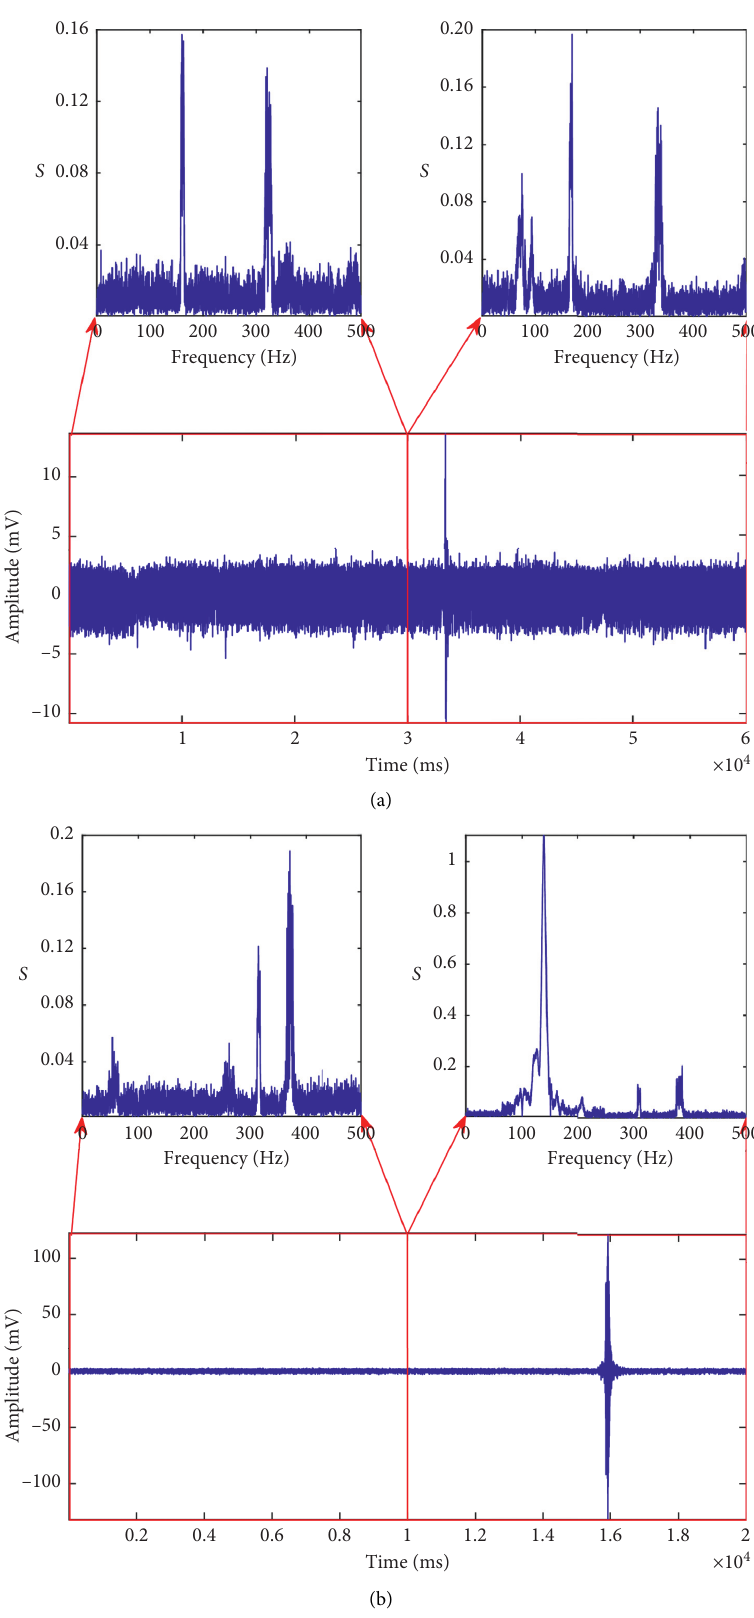
Figure 1: CSHF signal with (a) low signal-to-noise ratio and (b) high signal-to-noise